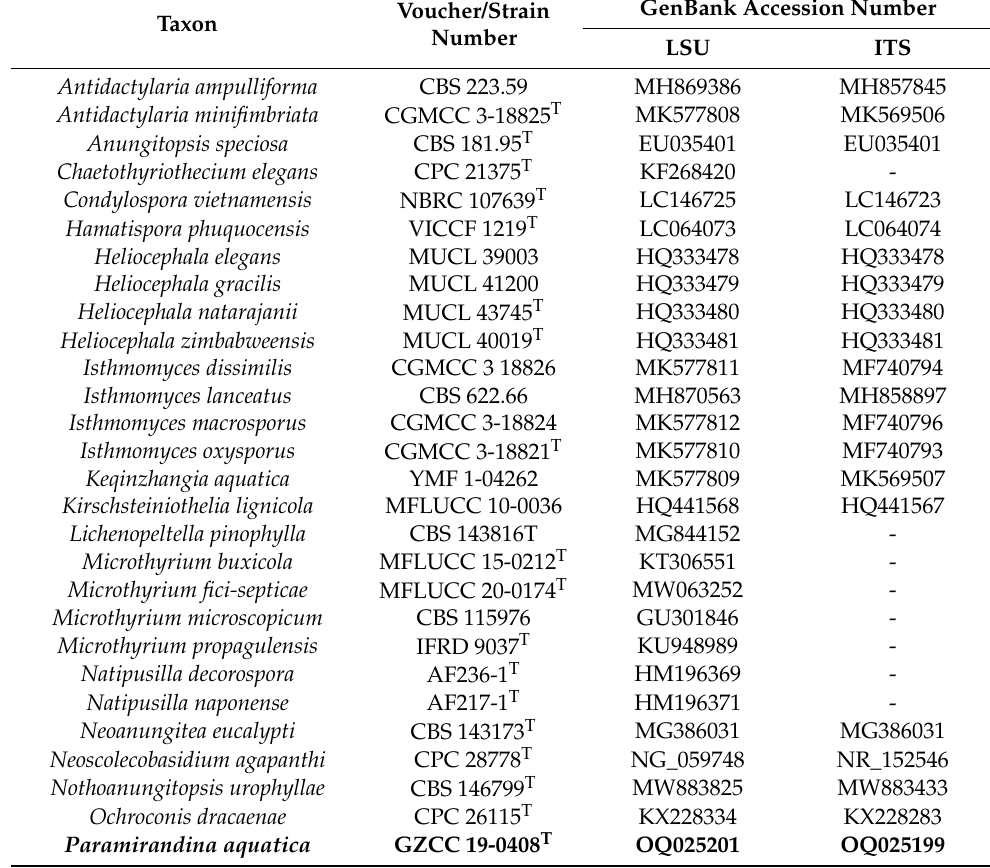
Table 1. Taxa used in the phylogenetic analyses and their GenBank accession numbers. T denotes ex-type strains. Newly generated sequences are in